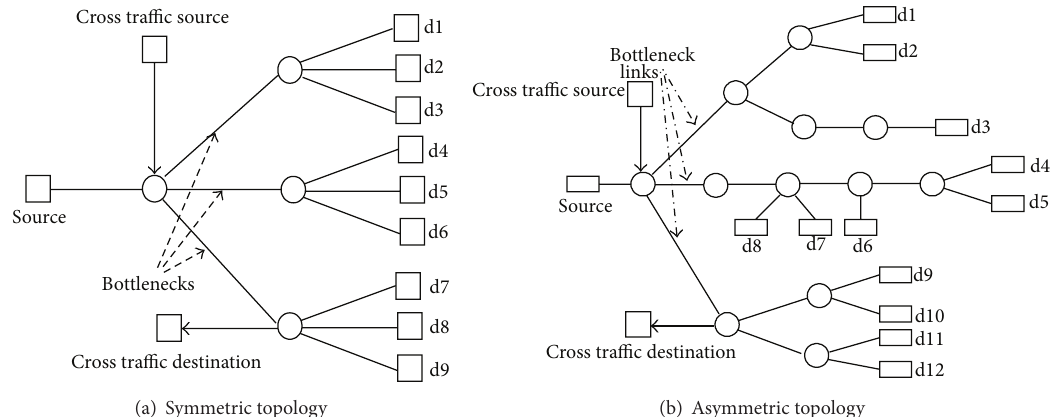
Figure 2: Symmetric and asymmetric topologies.